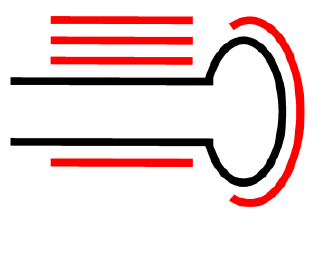
Figure 3. Alignment pattern expected from miRNA processing (Adapted from